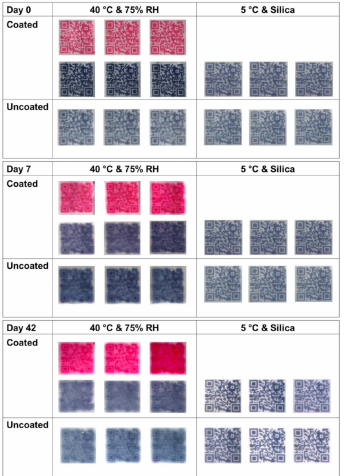
Figure 5. Photographs of DEEP, uncoated and coated, stored in two different conditions at 0 days, 7 days and 42 days of